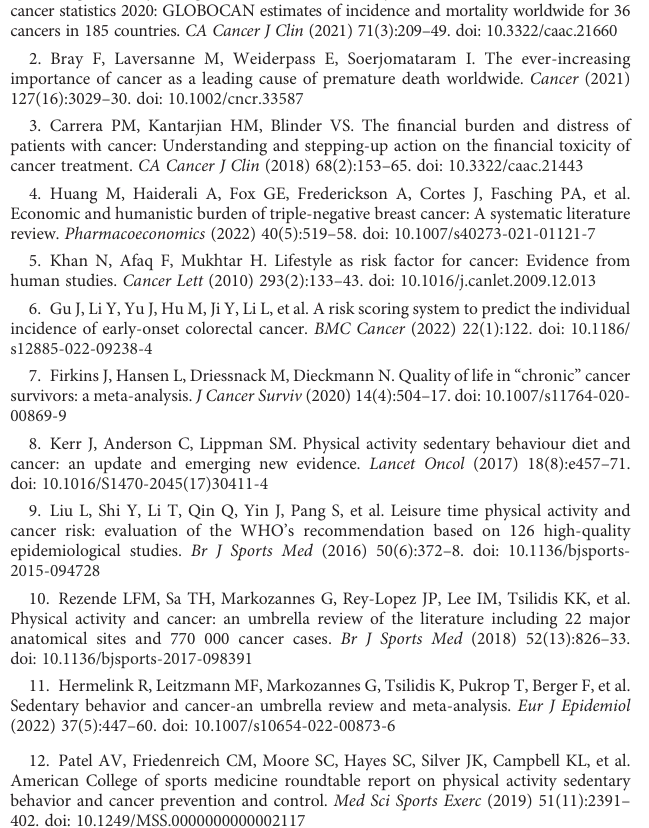
SUPPLEMENTARY FIGURE 1 The collaborative relationships between different